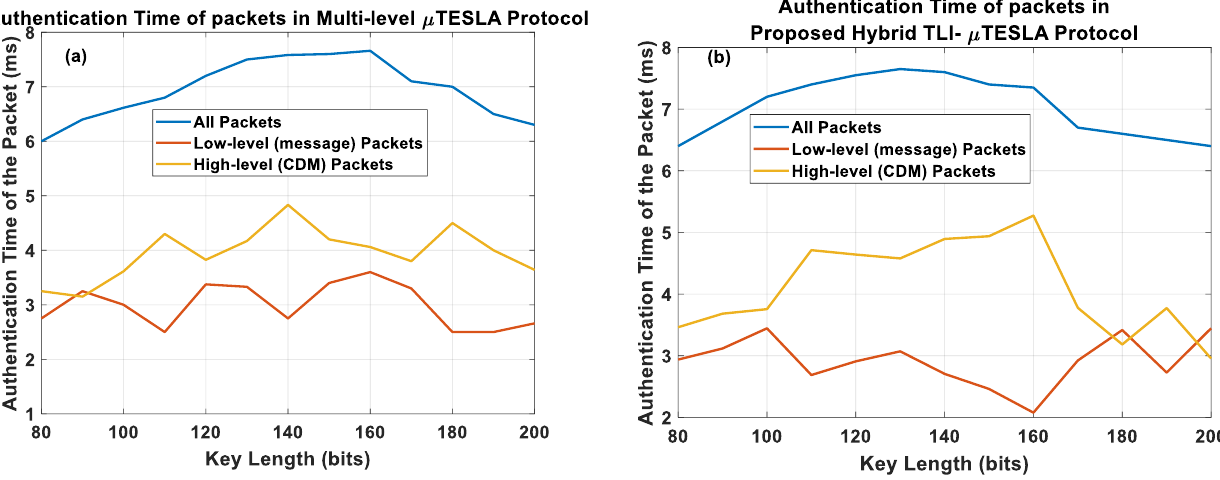
Figure 9. Simulation results showing the composition of the authentication time of the low-level (message) packets (red line), authentication time of the high-level CDM packets (yellow line), and overall authentication time of the packets (blue line) in ( a ) Multilevel-µTESLA and ( b ) Proposed Hybrid TLI-µTESLA protocols using SHA-2 hash function.